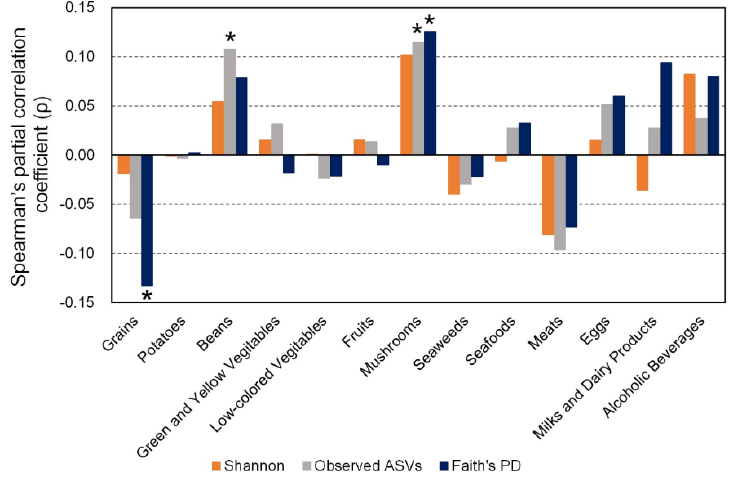
Figure 1. Gut microbiota of the subjects in this study. ( A ) Total gut bacterial counts. ( B ) Abundance of bacteria at the phylum level.